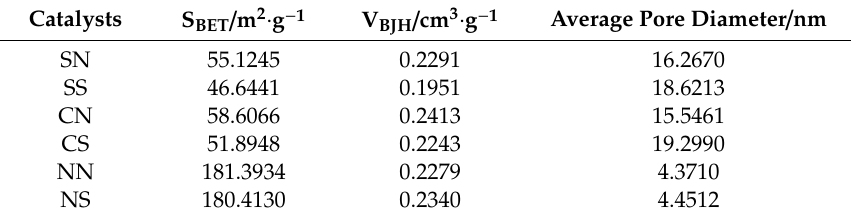
Table 2. Surface characterization of titanium modified FeMgO x catalysts with di ff erent